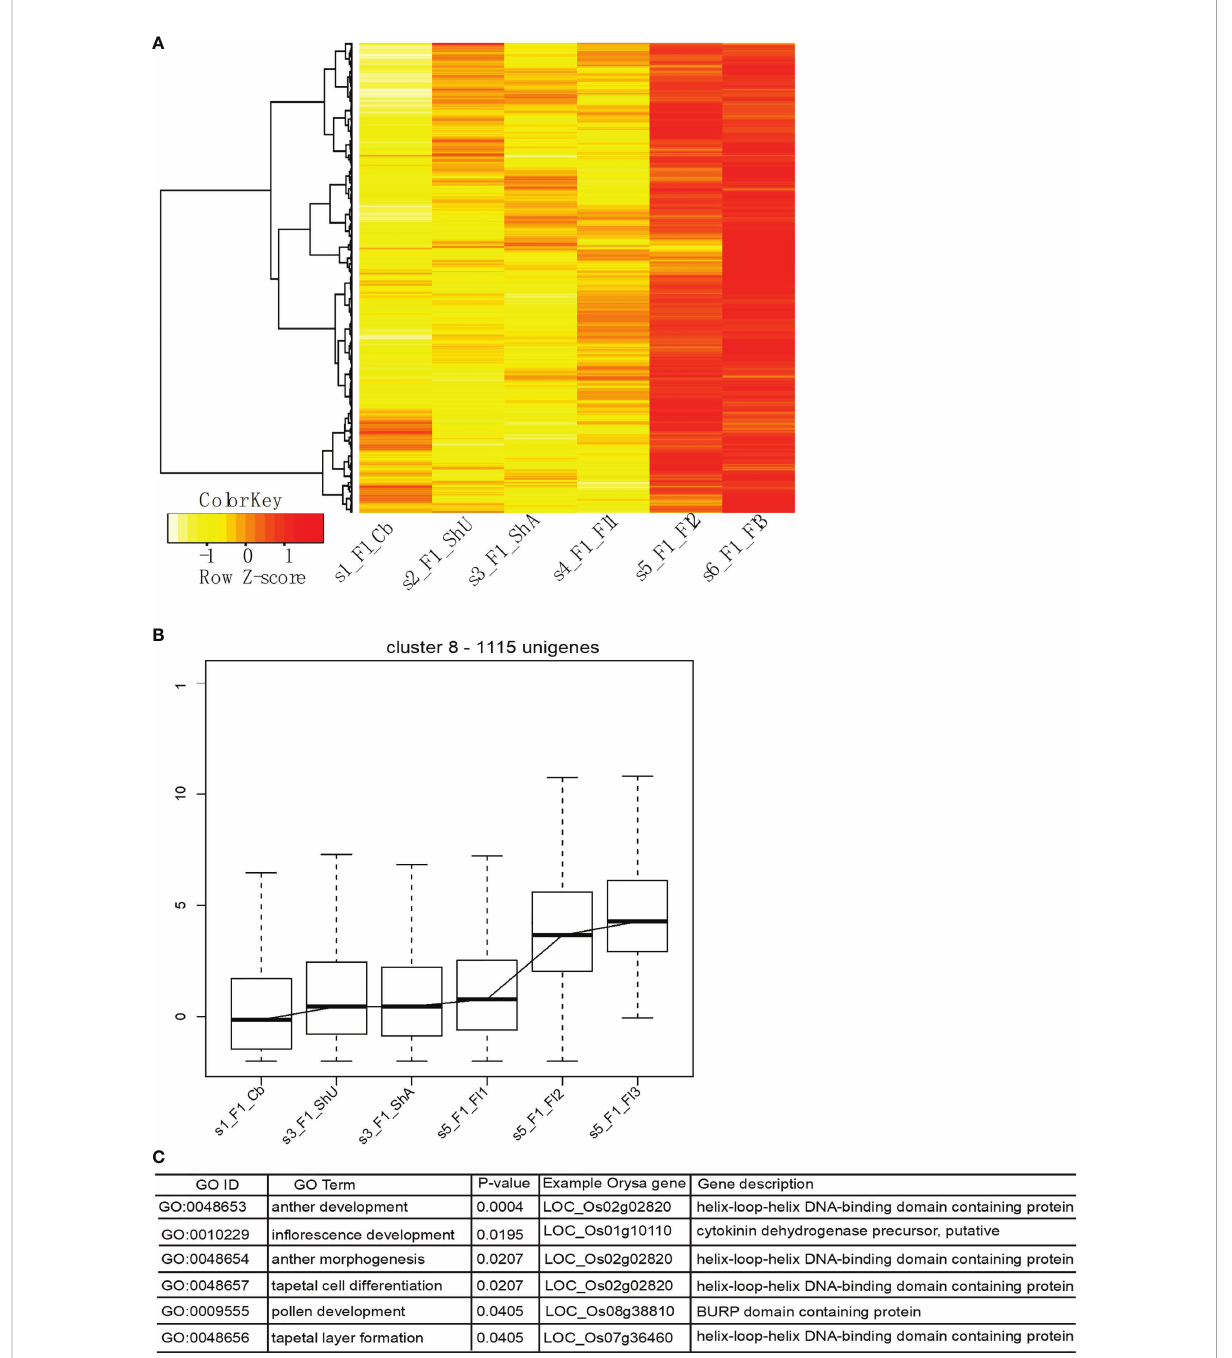
FIGURE 5 The major transcriptional pro fi le includes genes highly expressed in fl ower tissues and functional enrichment shows the enriched Gene Ontology Biological Process terms. (A, B) show the expression pro fi le of genes in this cluster, and (C) shows the enriched functional categories and representative gene in